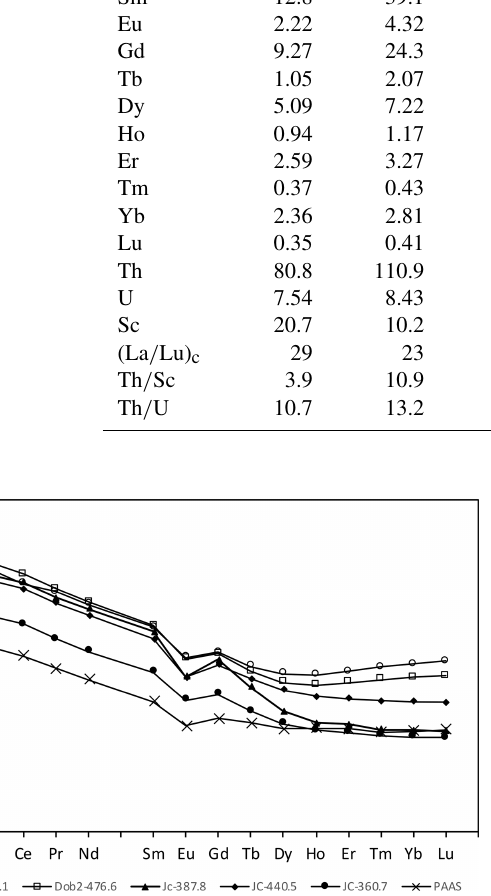
Figure 9. REE patterns of the fault gouge illites. Note that the illites are substantially enriched in light REEs (LREEs) relative to